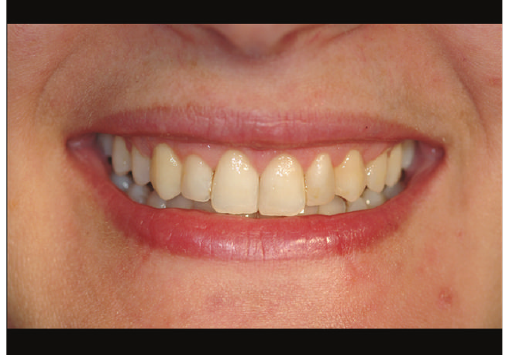
Figure 12: Posttreatment view of patient